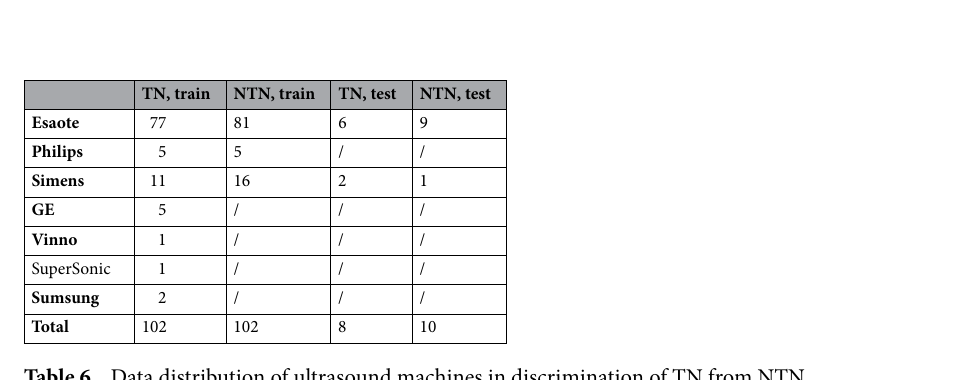
Table 6. Data distribution of ultrasound machines in discrimination of TN from